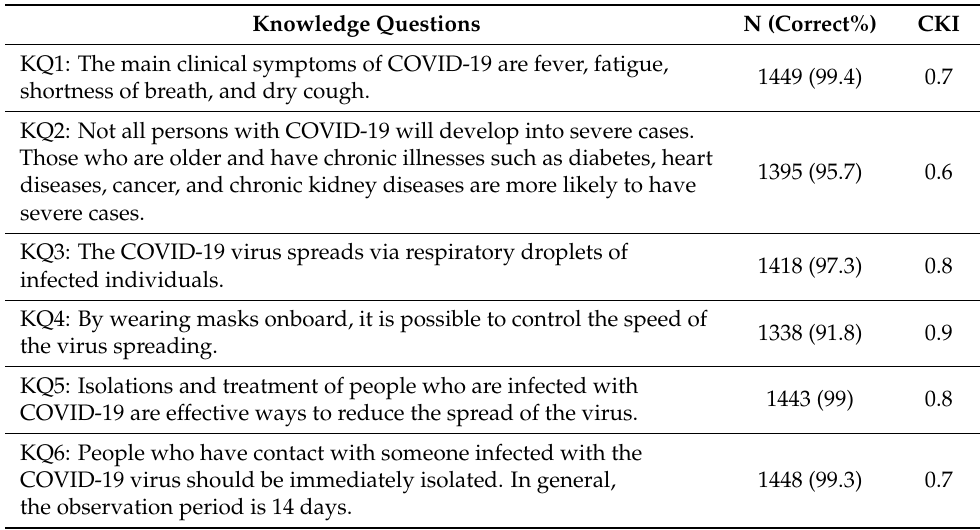
Table 3. Frequency of correct answers to the knowledge questions. CKI: Cohen’s Kappa Index.